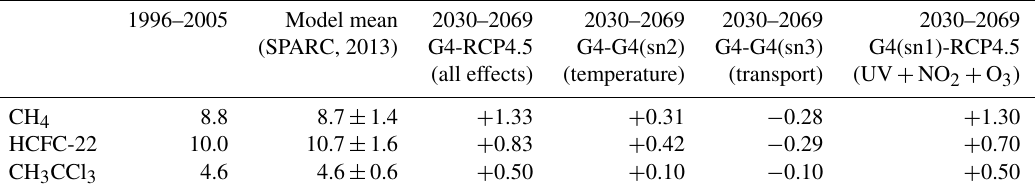
Table 6. Atmospheric lifetimes (years) calculated in the ULAQ-CCM (experiment b in Table 1), relative to three species that include an OH reaction sink (i.e., CH 4 , HCFC-22, CH 3 CCl 3 ). CH 4 is predicted with the FBC approach; the other two species with specified surface mixing ratios (unchanged between G4 and RCP4.5). The first column shows year 2000 values (as an average over the 1996–2005 decade); the second column shows a model mean value from the SPARC (2013) report on lifetimes. Subsequent columns show the calculated lifetime anomalies due to sulfate geoengineering (average 2030–2069). Inside the brackets we highlight the physical and chemical effects driving the lifetime changes (see text).